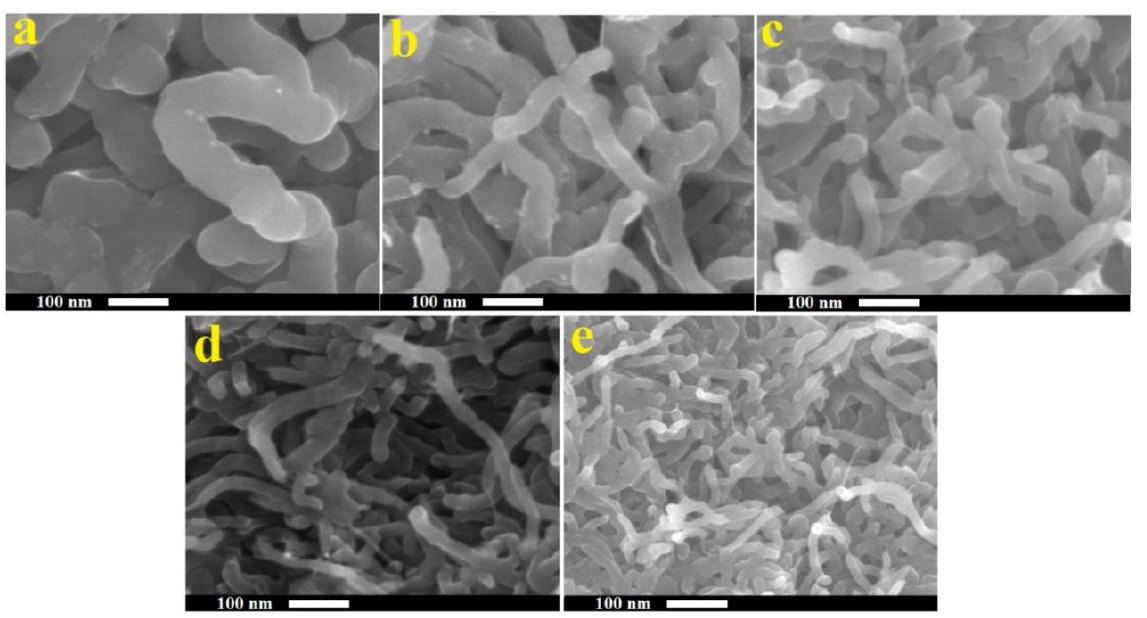
Figure 3. SEM images at the same magnification of MWCNTs/PPy nanocomposites ( a : PN1, b : PN2, c : PN3, d : PN4, e : PN5).